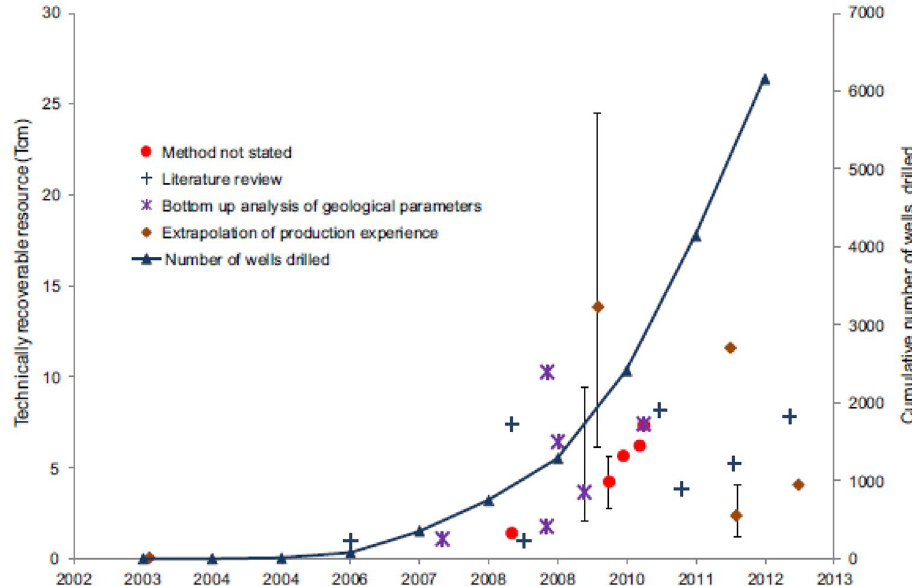
Fig. 2 Uncertainties in reserve assessment of shale gas reser- voir (Adapted from McGlade et al.